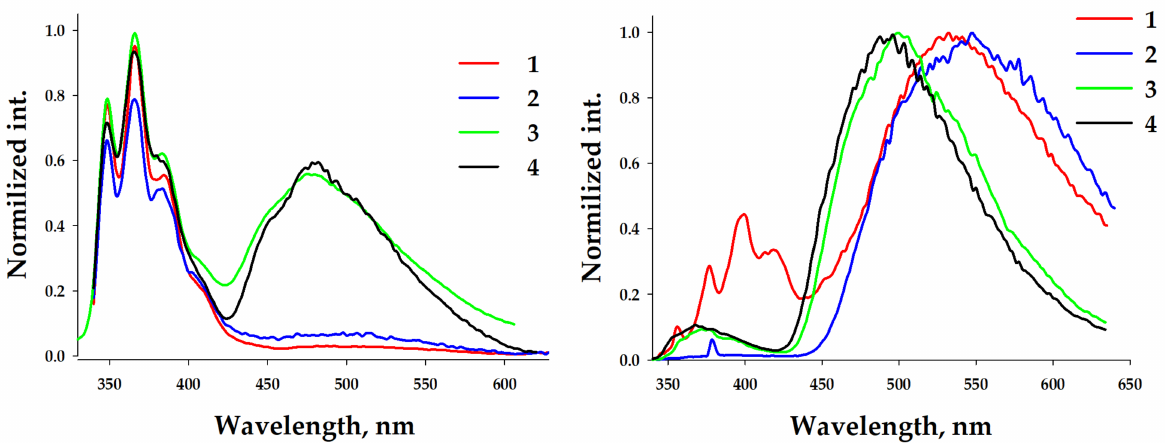
Figure 5. Normalized emission spectra of frozen DCM solutions of complexes 1 – 4 at low ( Left ) and high ( Right ) concentrations. λ ex = 325